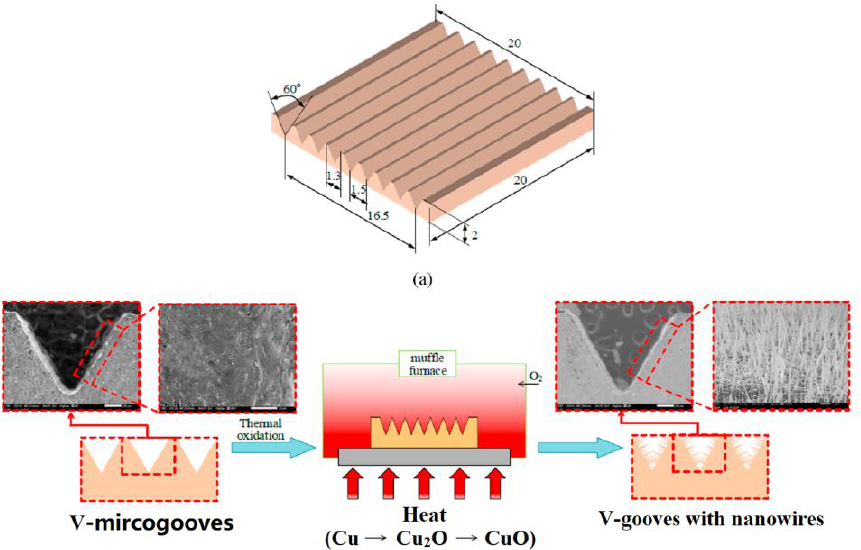
Figure 10. Schematic of the manufacturing process for the V-shaped microgrooves; ( a ) geometric dimensions; ( b ) schematic of the thermal oxidation process [24].